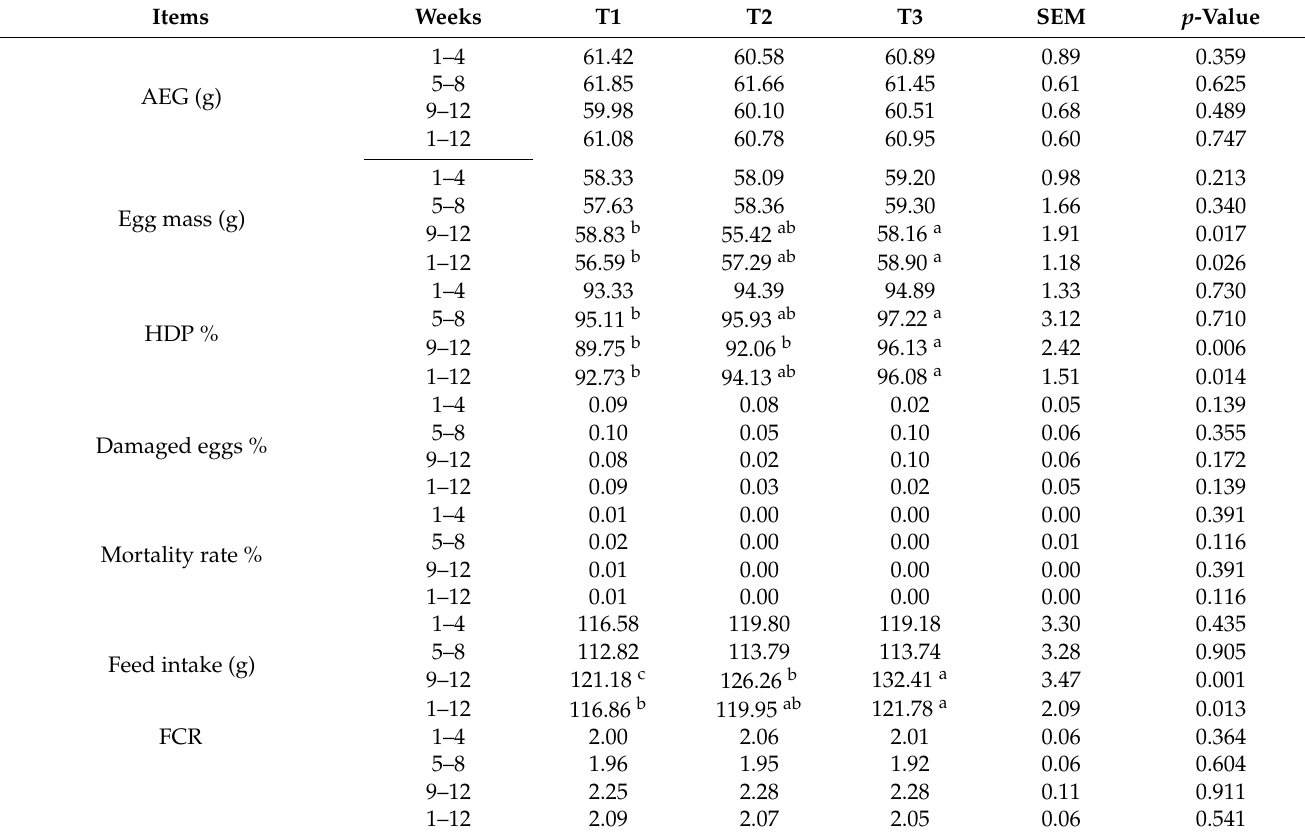
Table 2. Effect of dietary fructooligosaccharides on performance of laying